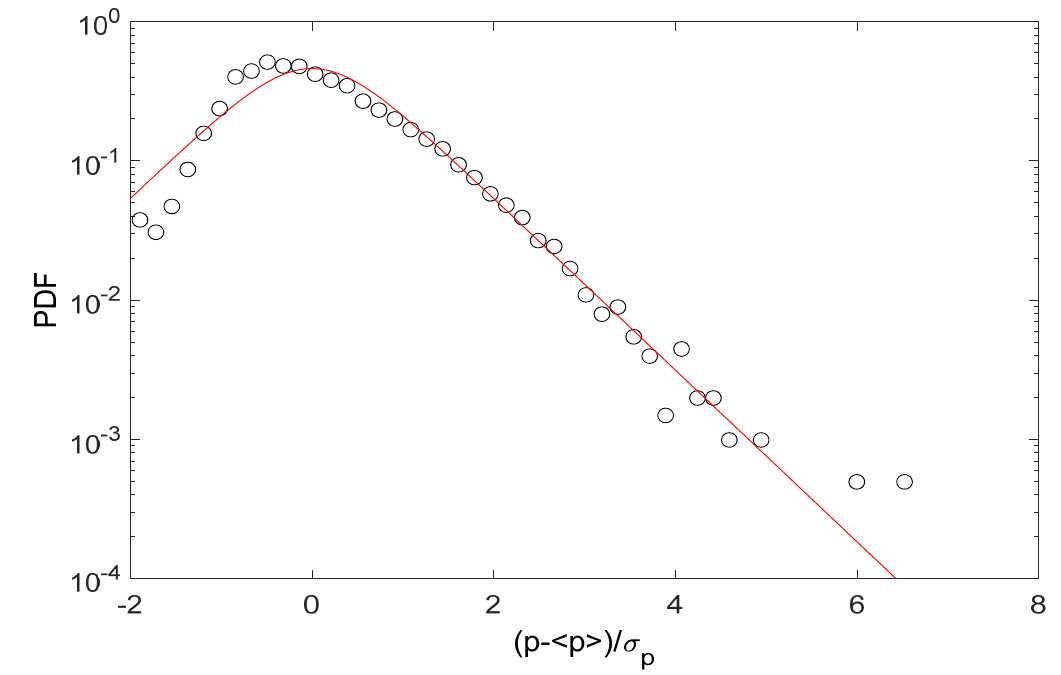
Figure 7. PDF of the intermittency time  t computed from a signal extracted randomly from the entire database (circles) and the analytical prediction provided in [26] (red line).